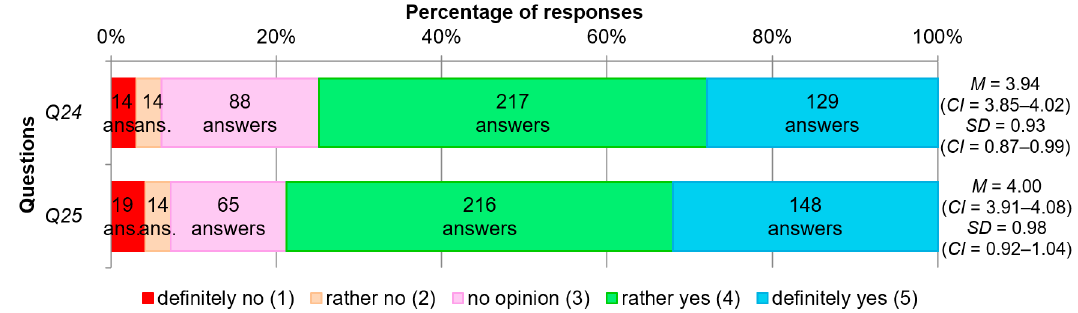
Figure 11. Assessment of legal factors influencing the choice of an alternative energy source for heating water in residential buildings ( M —average, SD —standard deviation, CI —confidence interval, questions numbers ( Q ) according to the Appendix A).